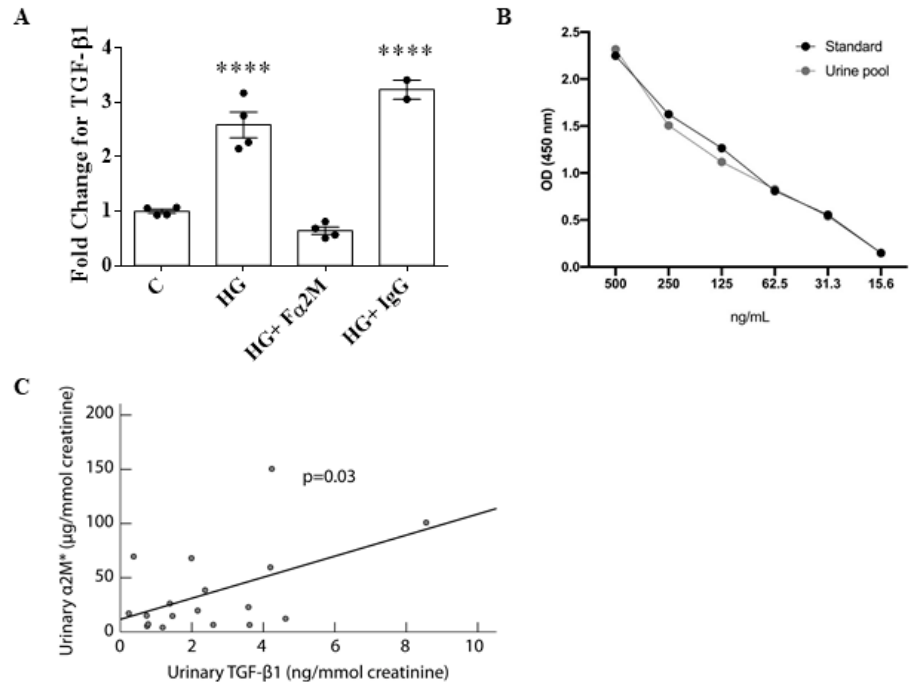
Figure 7. TGF β 1 production is dependent on α 2M* in MCs, with urinary TGF β 1/ α 2M* association in patients with established DKD. ( A ) Neutralization of α 2M* with F α 2M (2 µ g/mL) prevented high glucose (HG, 48 h)-induced secretion of TGF β 1 into the medium, as assessed by ELISA ( n = 4, **** p < 0.0001). Control IgG had no effect. ( B ) Correlation of spiked urine to standard concentrations of α 2M* in human urine samples confirmed the assay’s ability to quantify α 2M* in urine samples. ( C ) There was an association between urinary α 2M* and TGF β 1 in patients with established DKD ( p = 0.03, Pearson correlation).